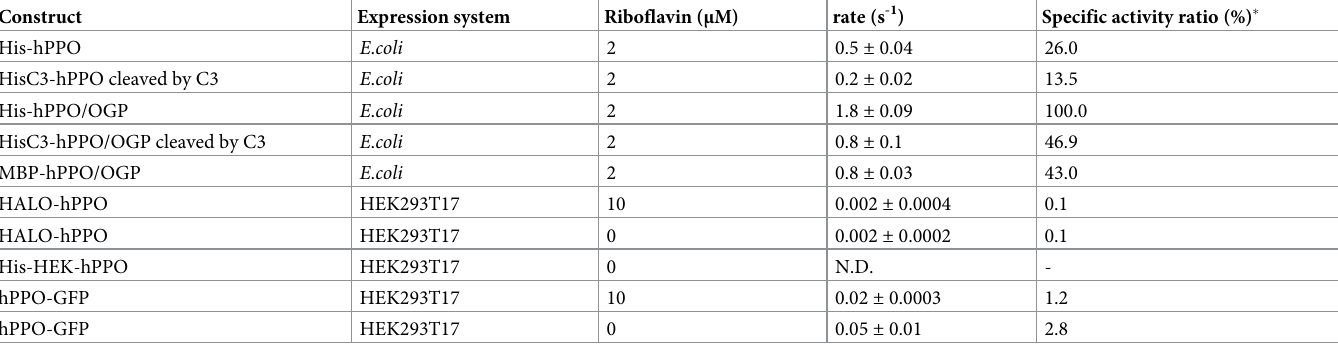
Table 1. Enzymatic activities of hPPO constructs using protoporphyrinogen IX as a